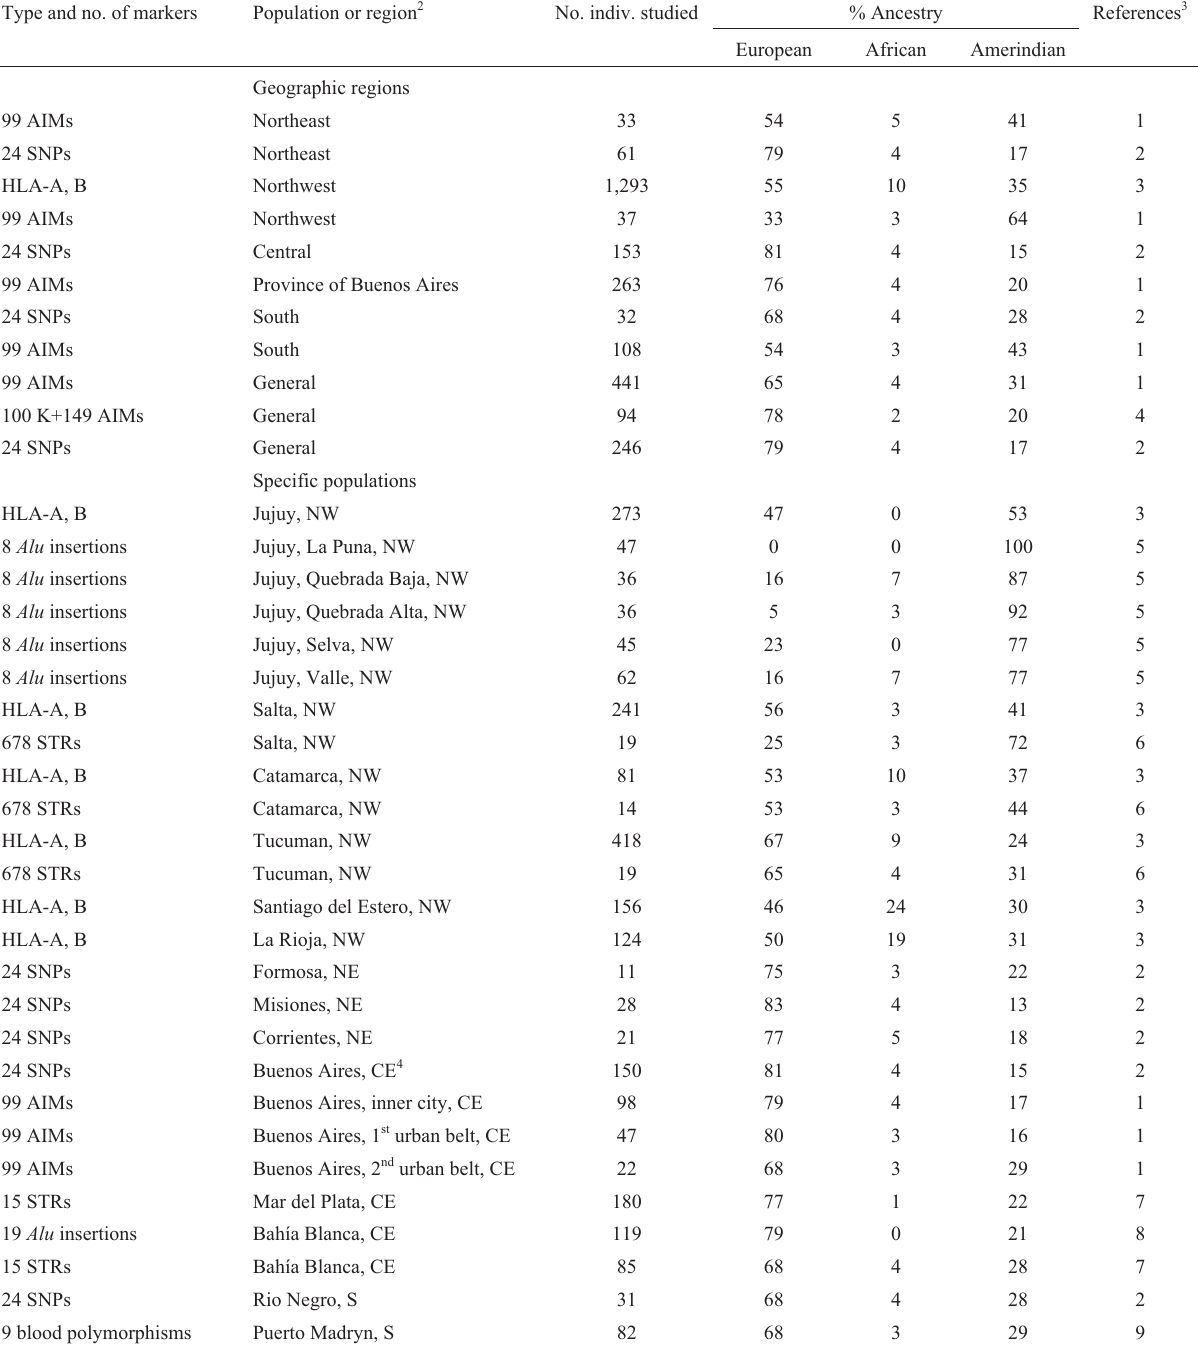
Table 6 - Molecular autosome estimates of parental continental ancestry in different segments of the Argentinian population 1 . Type and no. of